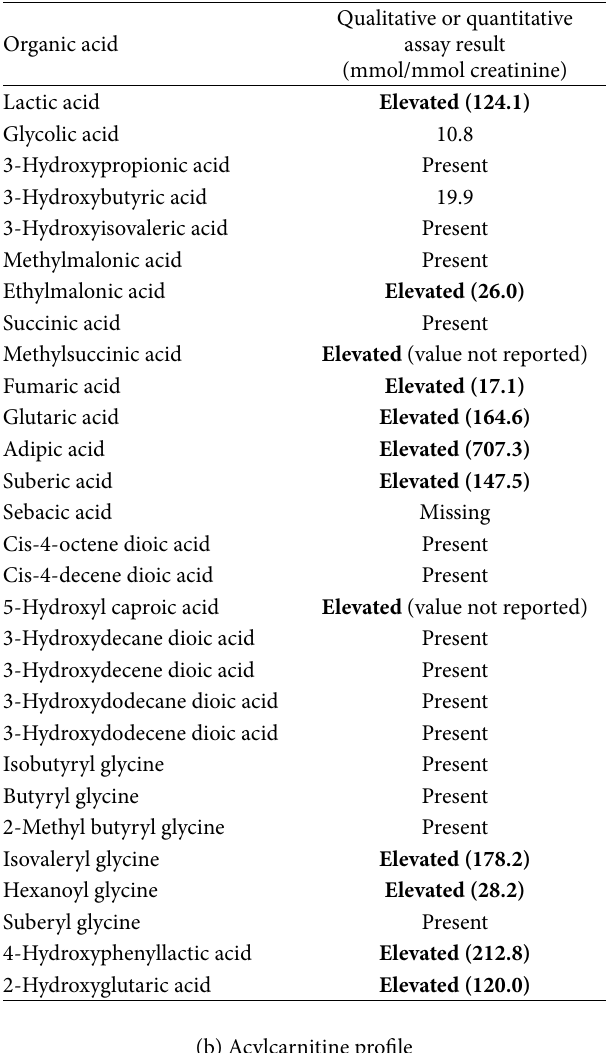
Table 1: The work-up leading to the diagnosis of DMAD in our